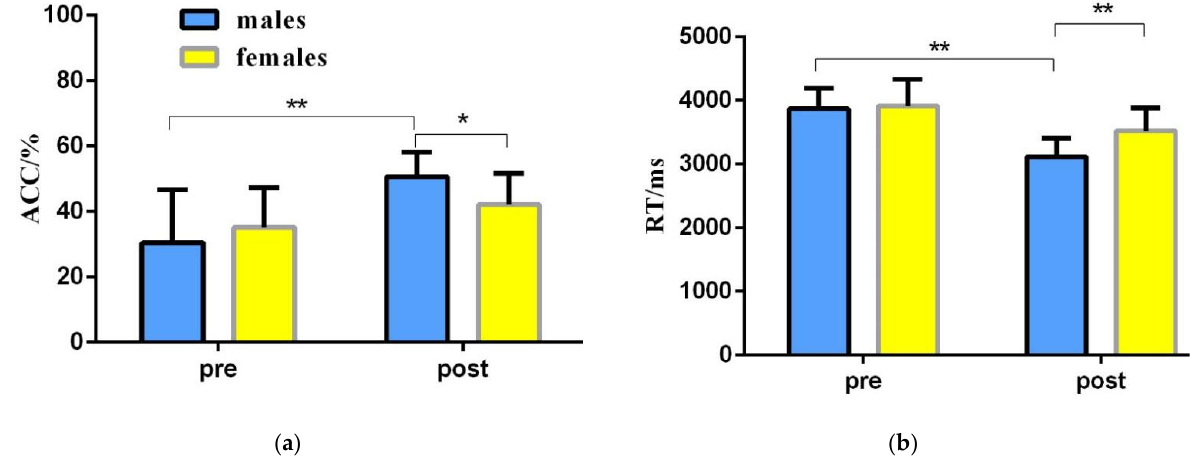
Figure 6. Changes in spatial memory behavior results of college students of different genders before and after orienteering intervention in the experimental group. ( a ) Changes in the correct rate of college students of different genders before and after the O&M intervention; ( b ) changes in the response time of college students of different genders before and after the O&M intervention; blue represents male